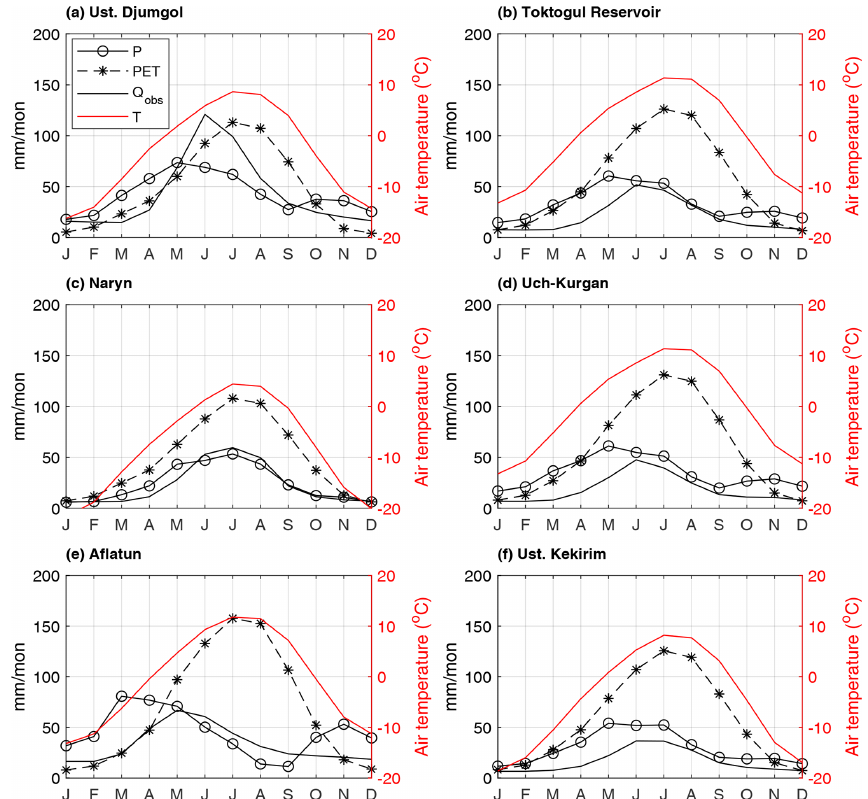
Figure 2. Climatology of monthly mean temperature ( T ), potential evaporation (PET), precipitation ( P ) and observed discharge ( Q obs ) averaged for each sub-catchment for the calibration period 1951–1970. Temperature and PET are from the ERA5 and ERA5 back extension dataset, precipitation is from the APHRODITE dataset and observed discharge is from the Global Runoff Data